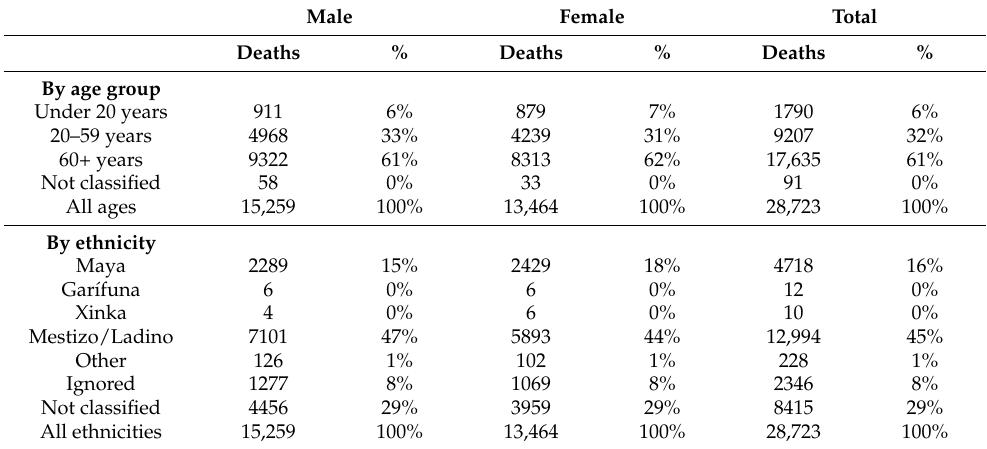
Table 1. Number of deaths from chronic kidney disease, Guatemala 2009–2019 ( N = 28,723). Male Female Total Deaths % Deaths % Deaths